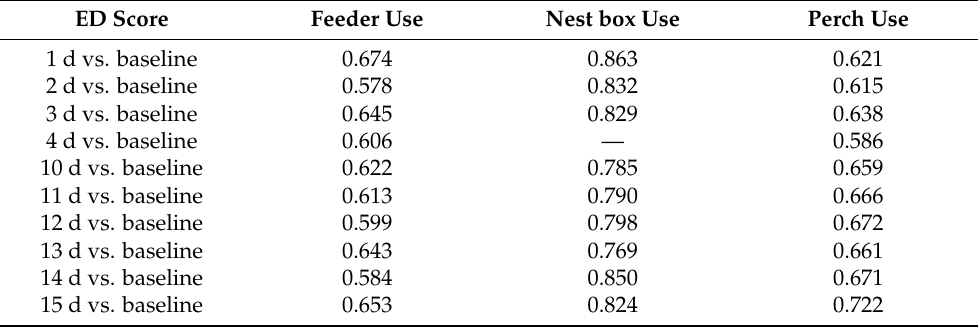
Figure 5(a2,b2,c2), as well as Figure 5(a3,b3,c3), show the diurnal pattern of hens using each space at 1 d to 4 d and 13 d to 15 d. The ED scores for the diurnal pattern of each measure of space use on observation days after backpack placement, as well as the baseline, were shown in Table 5. For feeder use, the ED scores were generally lower than those on the days before equipping. For nest box use, the ED scores at 10 d to 13 d were relatively lower than those on other days after being backpacked. The ED scores for perch use were reduced at 1 d (0.621), dropped to a minimum at 4 d (0.586), and increased to 0.722 at 15 d. Table 5. The Euclidean Distance (ED) score for the diurnal pattern of hens using the feeder, nest box, and perch on observation days after the backpack placement, as well as the baseline. ED Score Feeder Use Nest box Use Perch Use 1 d vs. baseline